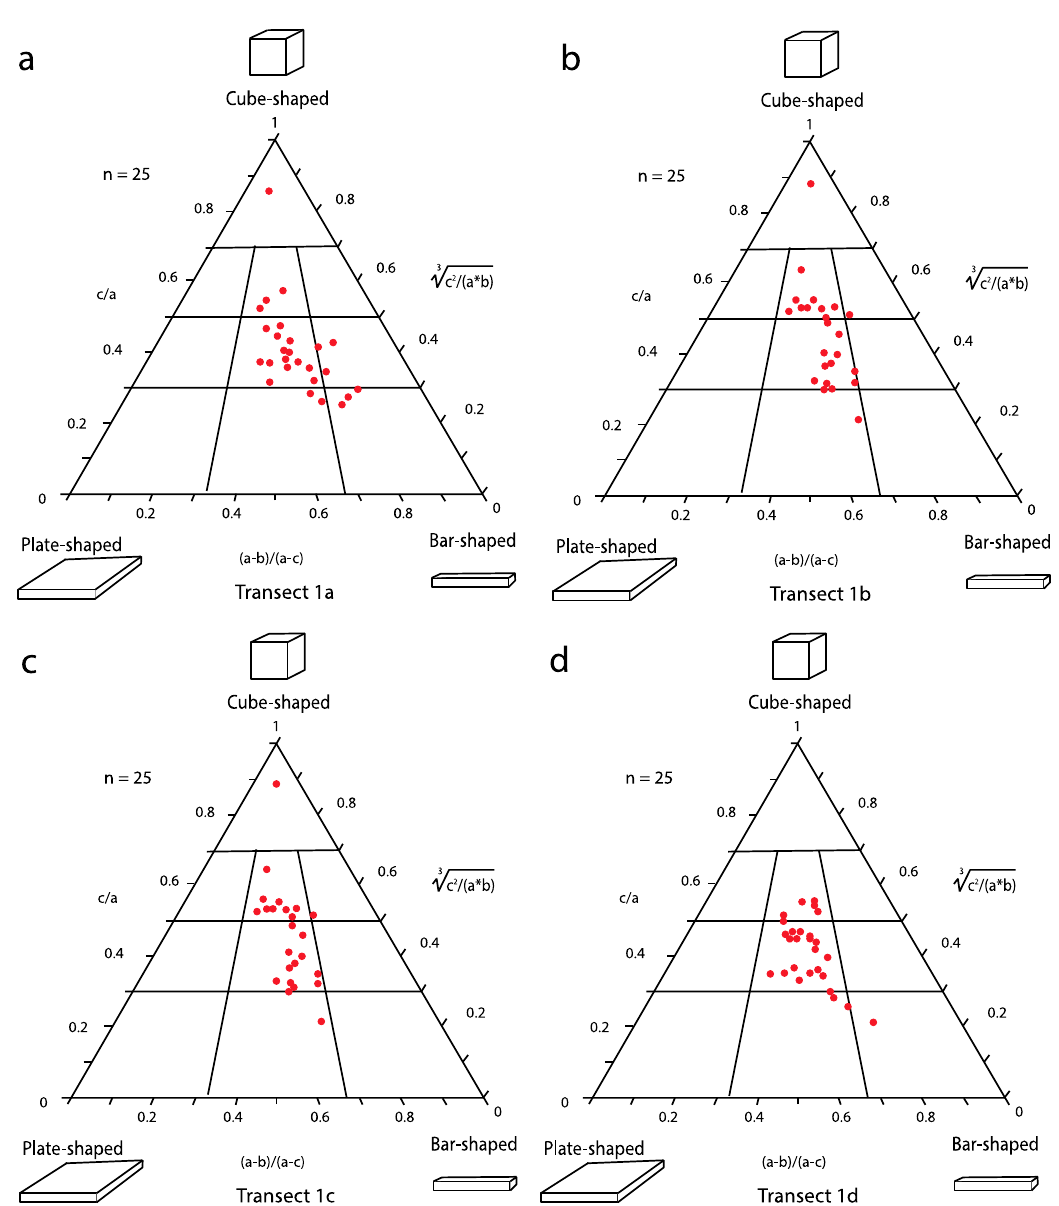
Figure 7. Set of four triangular Sneed-Folk diagrams used to appraise variations in boulder shape on barrier #1; ( a ) Trend for boulders from Transect 1a; ( b ) Trend for boulders from Transect 1b; ( c ) Trend for boulders from Transect 1c; ( d ) Trend for boulders from Transect 1d. Note the similarity in slopes from sample to sample.